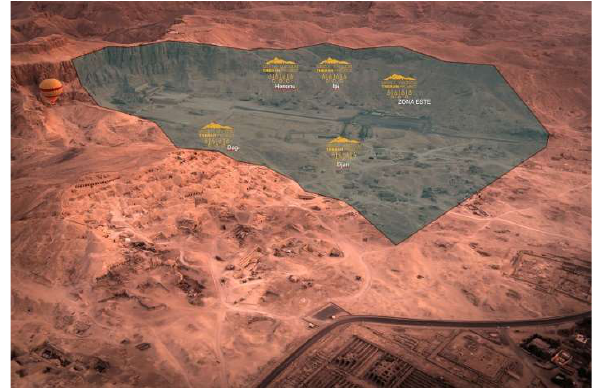
Figure 2. Aerial view of Deir